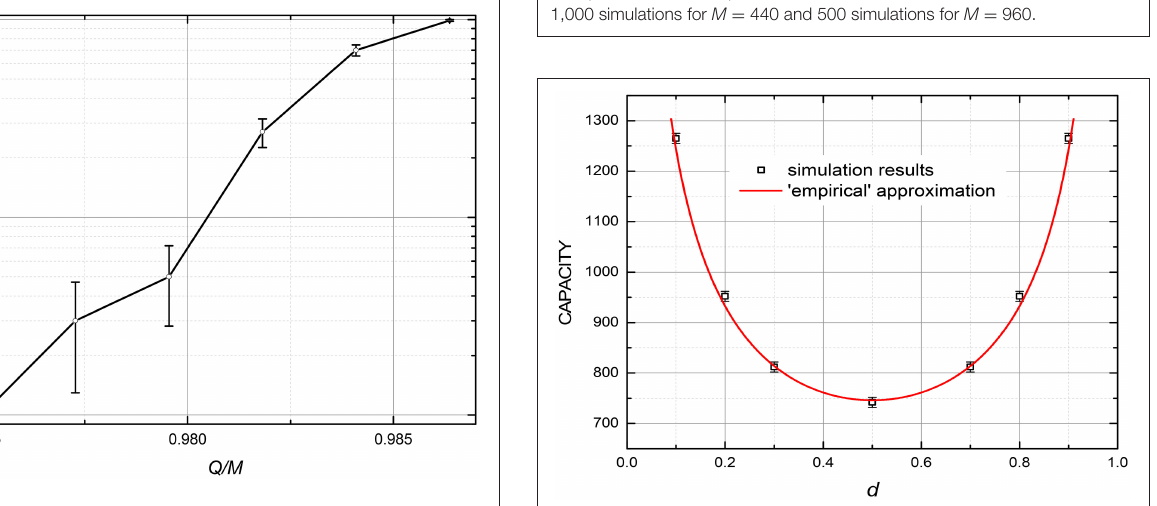
440. The smooth curve = 1/[ d (1 – d )] 1 / 2 . The error bars ∞